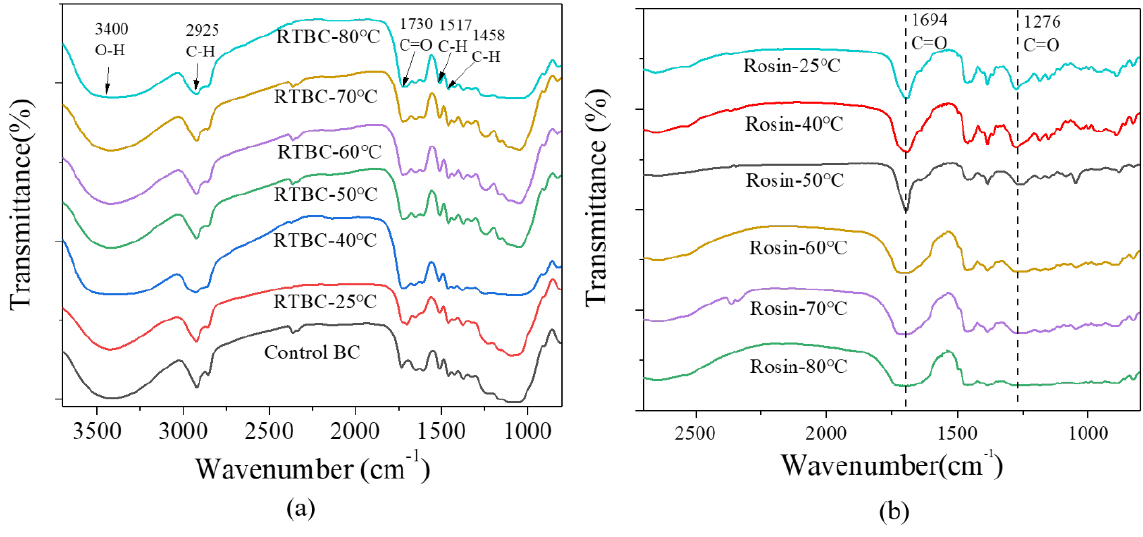
Figure 5. Fourier transform infrared spectroscopy spectra of ( a ) control bamboo culm and rosin-treated bamboo culm (RTBC) at different temperature; and ( b ) rosin at different temperature.